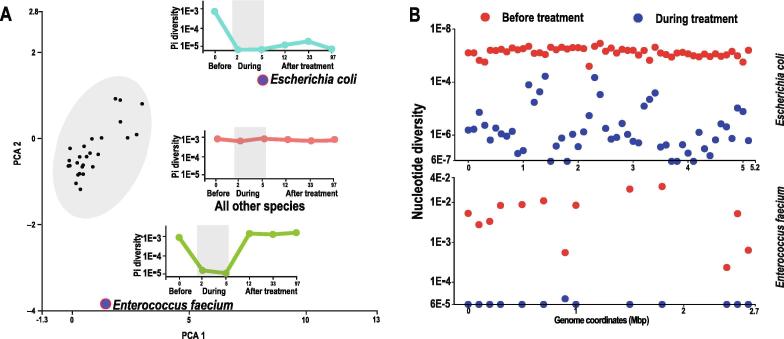
The variation of the genome-wide nucleotide diversityA. PCA based on the genome-wide nucleotide diversity at different time points in the treated subject. Each dot represents one species. Two species, Escherichia coli and Enterococcus faecium show exceptional genome-wide selective sweeps. Three sub-figures describing the pattern of the temporal variation at the genome-wide diversity were shown juxtaposed with the species. B. The nucleotide diversity before and during treatment across the genome coordinates in Escherichia coli and Enterococcus faecium in the treated subject.